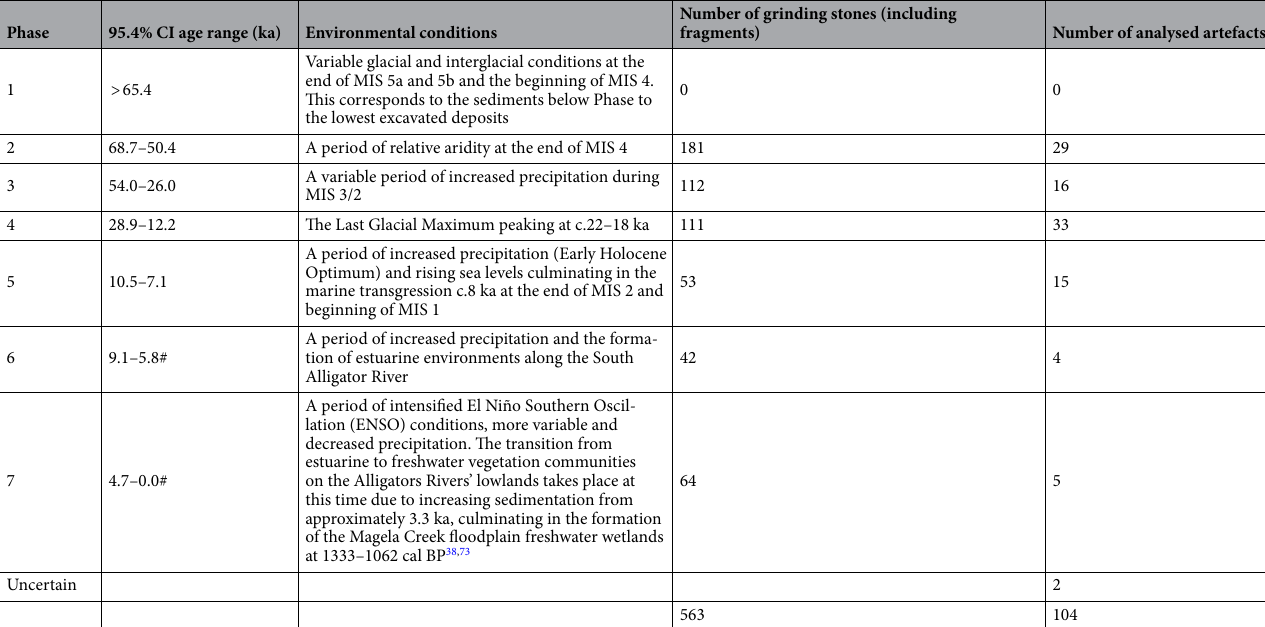
stones, pounders and whetstones 51 (Supplementary Material Section 2). Nearly all of the grinding stones were made from fine to medium grained local or exotic sandstone (n = 94, 90.4%) (Supplementary Material, Table S1). A single ground surface was identified on the majority of the grinding stones (76 of the 104 analysed stones, 73%), which were generally flat or, less commonly convex, in cross-section. Twenty-eight artefacts (~ 27%) dis- played two or more ground surfaces, making a total of 134 ground surfaces amongst the 104 analysed artefacts (Supplementary Material, Table S1). To determine whether the stones were used as upper (active), lower (pas- sive) or filing (passive) stones, we recorded the cross-section of the ground surfaces (e.g., convex, concave, flat, undulating), the size (length, width and height) of the stones, and the locations of grinding wear (Supplementary Material Section 2). Fifty artefacts (~ 48%) were classified as coupled stones—grinding stones that were used in a pair as either upper or lower stones to process an intermediate material. These included 25 upper stones (48% of the coupled stones, 24% of the analysed grinding stone assemblage), 17 lower stones (~ 34% of the coupled stones, 16% of the analysed grinding stone assemblage) and eight that could not be distinguished as upper or lower stones but still had other traces to indicate they were used as coupled stones (e.g., stone-on-stone grinding wear documented under the microscope). Upper and lower stones were distinguished by their size (upper stones usually being small enough to fit comfortably in the hand), and the cross-section of their ground surfaces. All of the upper stones displayed at least one or more convex ground surfaces, while the lower stones typically displayed flat or undulating ground surfaces (n = 12) or, less commonly, concave surfaces or depressions (n = 5). These included three mortar stones with macroscopically visible pitted depressions (GS56, GS32, and GS75 from Phases 4 and 2, respectively) (Fig. 2a), and a relatively large millstone fragment (GS73 from Phase 2) with deep, partial grooves (Fig. 2d), similar to those documented on Australian seed grinding implements in the arid interior 52 . Not surprisingly, the upper stones were much smaller than the lower stones, the largest of which had a mass of 539 g (L49, Fig. 2f), while some of the complete lower stones weighed up to 8 kg. A further 32 artefacts (~ 31% of the total analysed grinding stone assemblage) were classified as filing stones— grinding stones that were used as individual stone “files” to process and shape the worked material and generally displaying flat (n = 25) grinding surfaces. Seven of these artefacts also had wear consistent with their use as coupled stones, indicating that these implements were either multifunctional tools or had been used opportun- istically for multiple tasks. The remaining 29 artefacts could not be assigned a functional class as they did not retain sufficient features to confidently identify them as either coupled or filing stones. Traces of surface rejuvenation (i.e., pitting to roughen the grinding surface) were absent, with only three artefacts displaying macroscopically visible pitting from use and manufacture (see above). Negative flake removals from the surface/perimeter were documented on just two artefacts (L49 and GS 79 from phases 7 and 2, respectively), one of which was deliberately split prior to use (GS 79) (Fig. 2e, f).